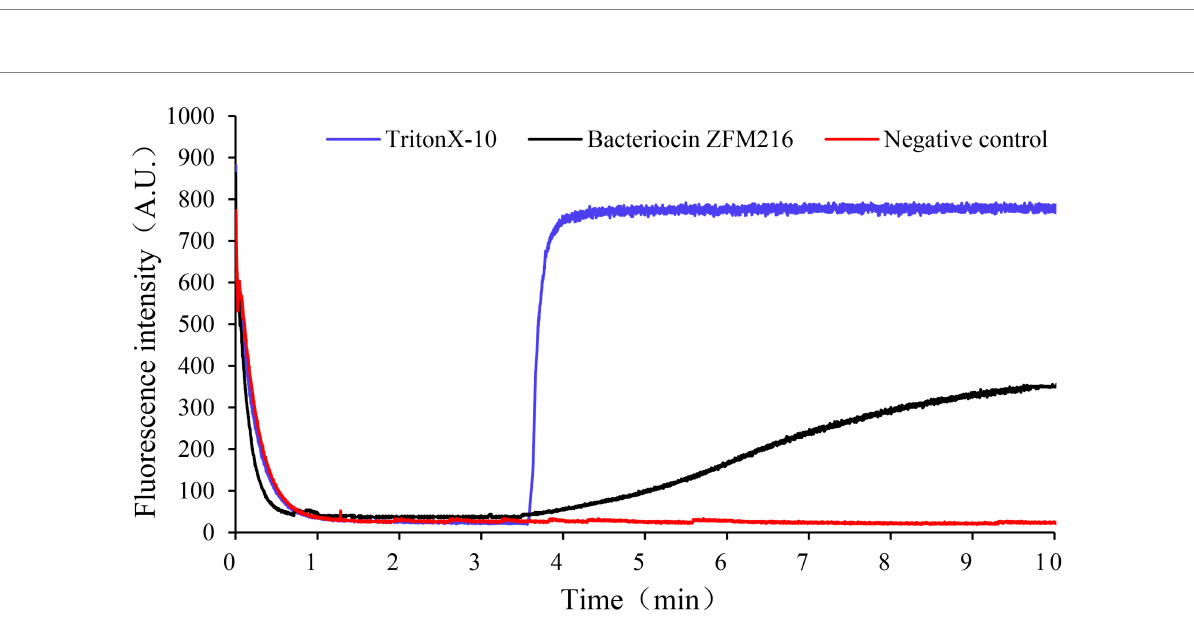
FIGURE 6 The effect of bacteriocin ZFM216 on the ΔΨ of indicator bacteria cell